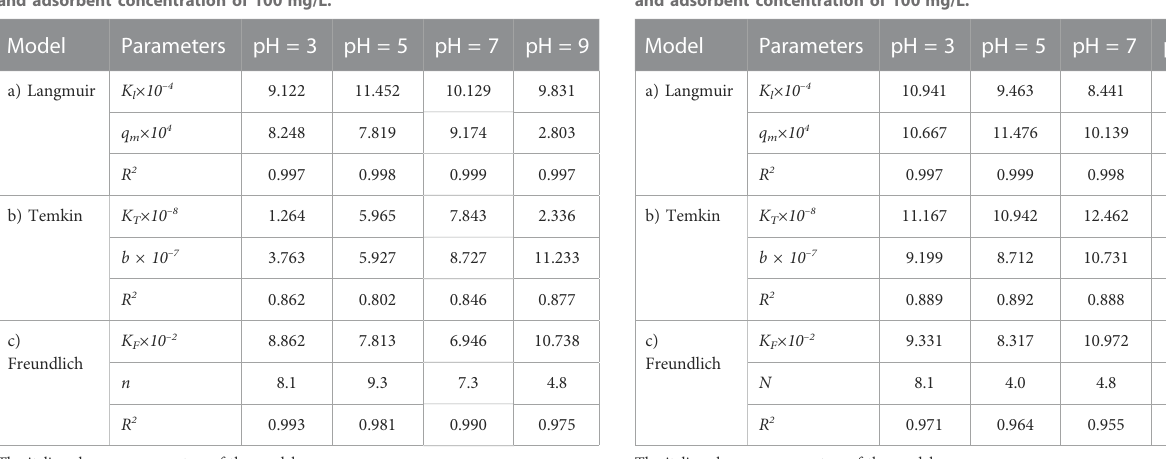
TABLE 10 Parameters of a) Langmuir, b) Temkin, and c) Freundlich isotherm models at different pH values using Oil sludge 3 as carbon active at T = 318 K and adsorbent concentration of 100 mg/L.